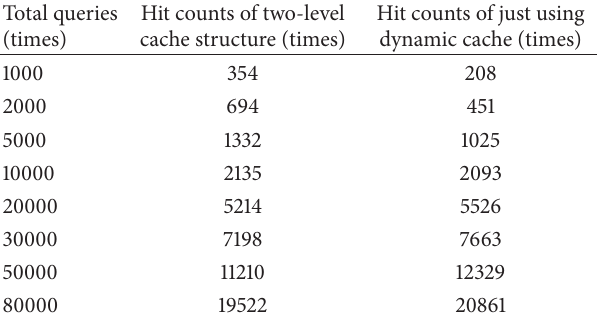
Table 2: The number of hits while dealing with different total